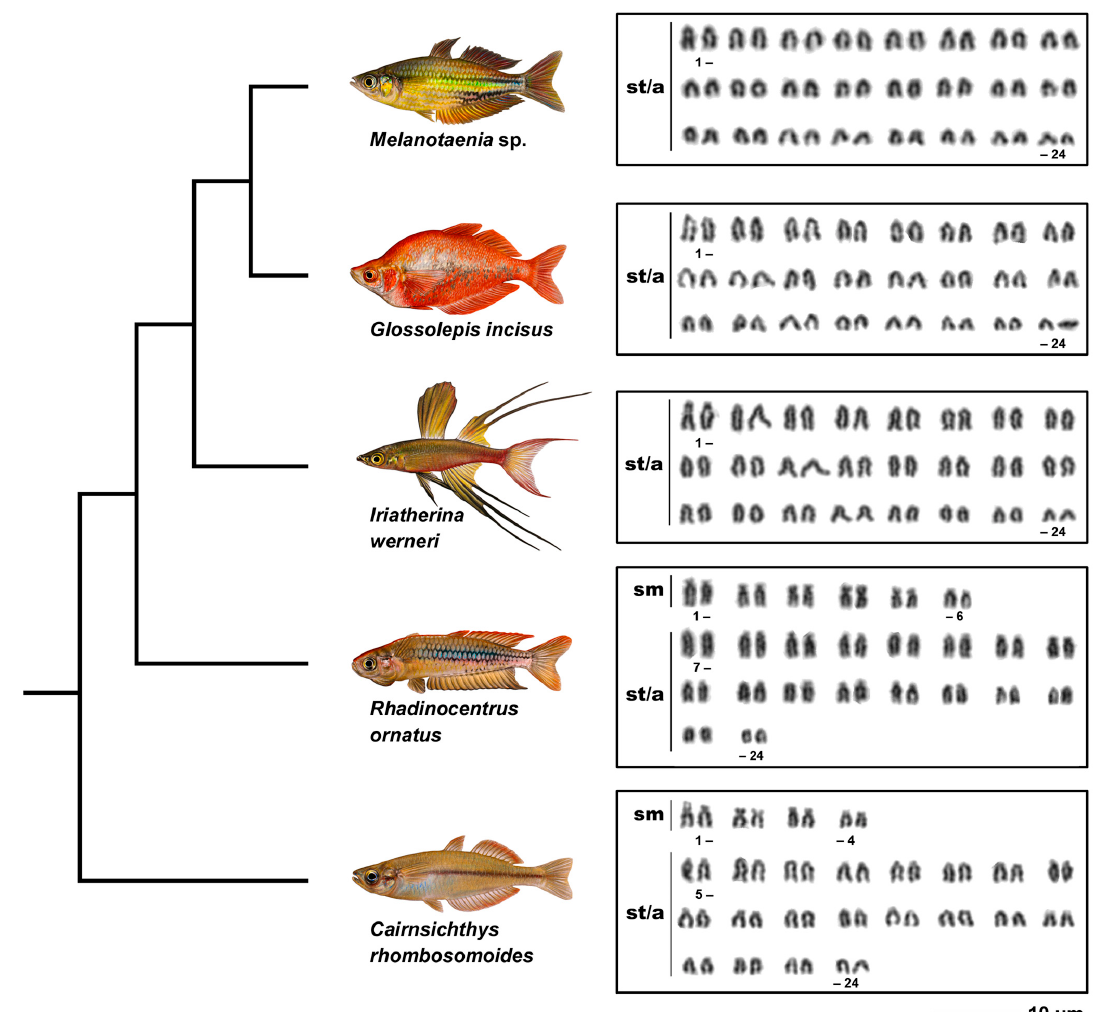
Figure 1. Phylogenetic relationships and karyotypes of studied species. Truncated phylogeny representing five species under study and their Giemsa-stained karyotypes. Phylogenetic relationships follow Unmack et al.